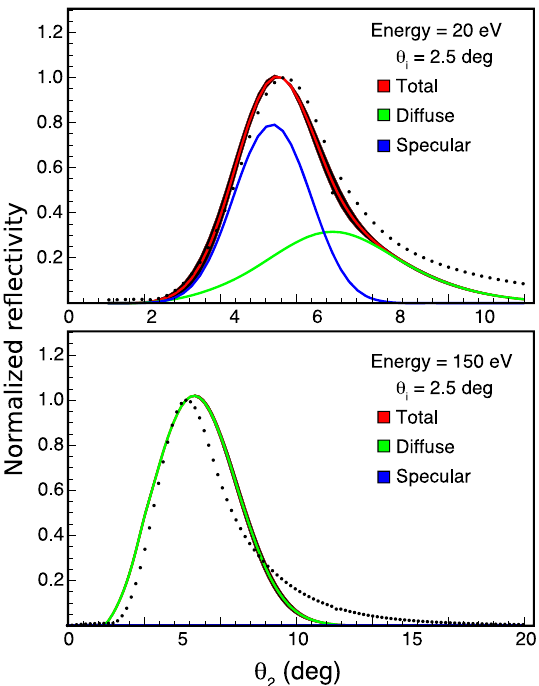
FIG. 26. Data sets Th5-Th6: Comparison between measure- ment and X-ray scattering model, θ 2 scans, for θ 1 ¼ 3 ° and various energies. The gray band represents the mean-prediction 95% confidence level associated with the fit. The relationship between θ and θ 1 is given in Sec. VA. i